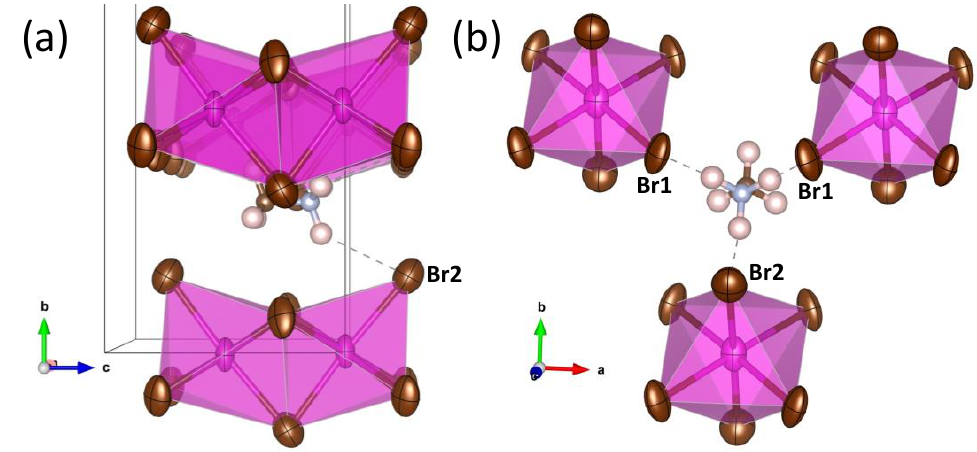
Figure 4. Views of MA with the expected hydrogen positions and H-bond interactions. ( a ) along a-axis direction, ( b ) along c-axis direction.